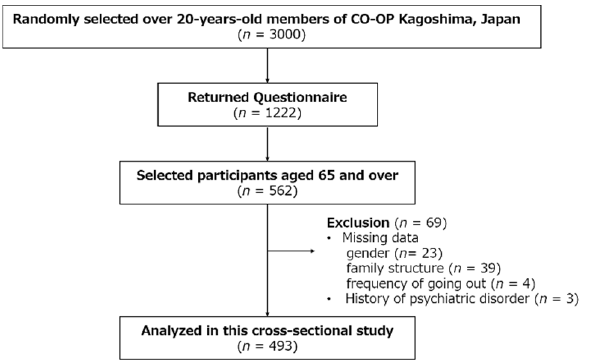
Figure 1. Flowchart of this